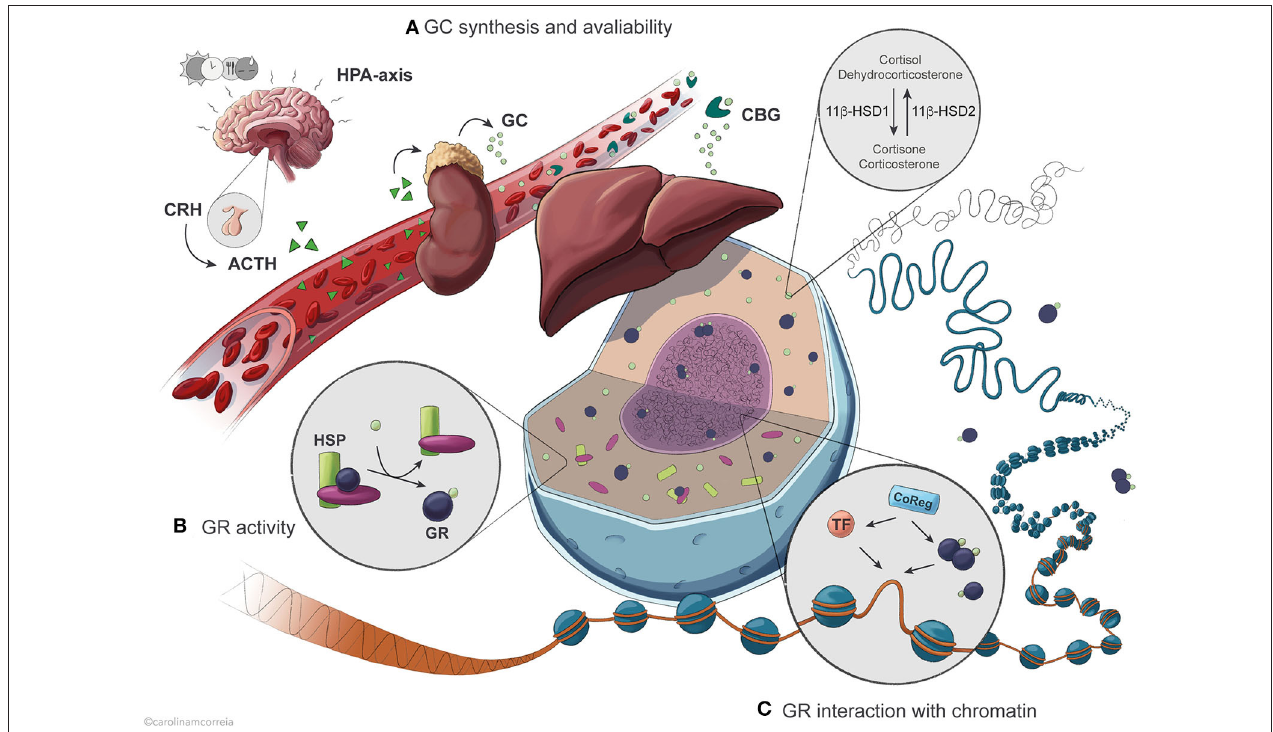
FIGURE 1 | Overview of the regulatory levels affecting GR activity in the control of hepatic transcription. (A) Circadian and ultradian synthesis of GCs is controlled by the HPA axis in response to external stimuli including feeding, stress, light and circadian timekeepers. Availability of active GCs is further influenced by binding to the serum protein CBG and by intracellular conversion catalyzed by the enzyme 11 β -HSD1/2. (B) Once in the cell, GCs are bound by the GR with an affinity that is conditioned by association with chaperone complexes containing HSPs, expression of specific GR isoforms and GR protein turnover. (C) GR exerts its action after translocation to the nucleus, where it binds GRE sequences in the DNA to regulate transcription of target genes as a result of dynamic interaction with different TFs and